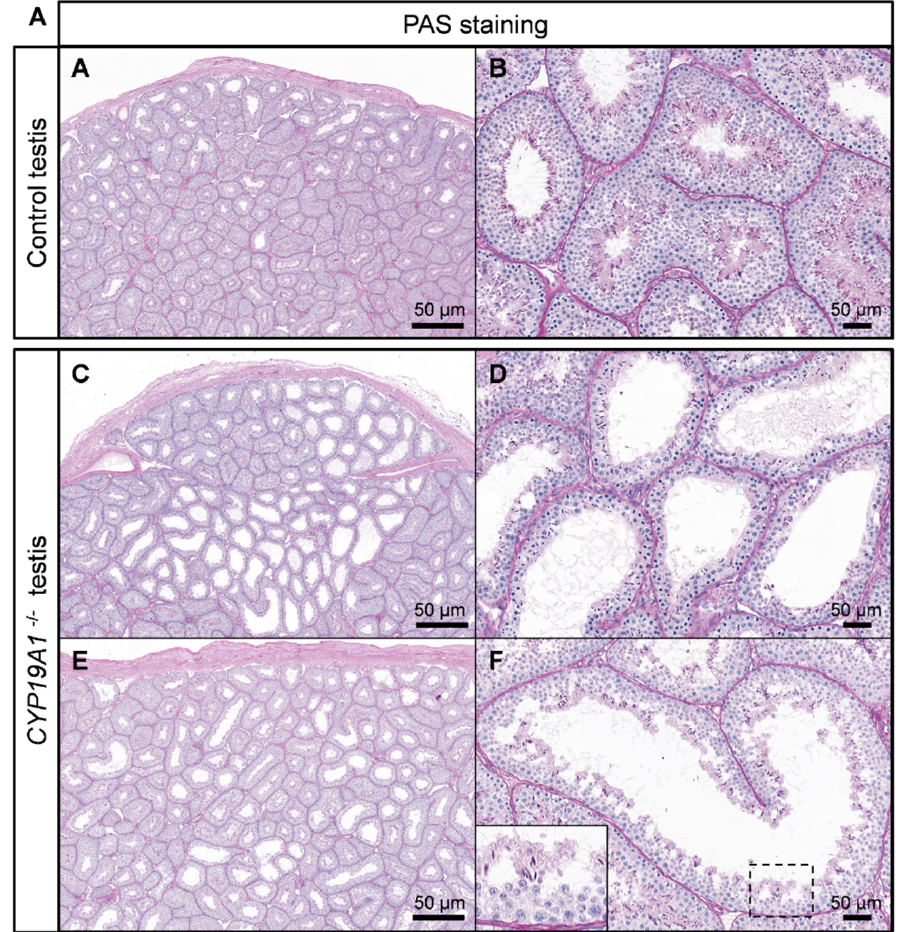
Figure 4. Spermatogenesis defects in absence of estrogen production. ( A , B ) PAS staining on control testis. ( C , F ) PAS staining on CYP19A1 − / − testis from two different rabbits ( C – F ). Males are 2 to 3 years old.